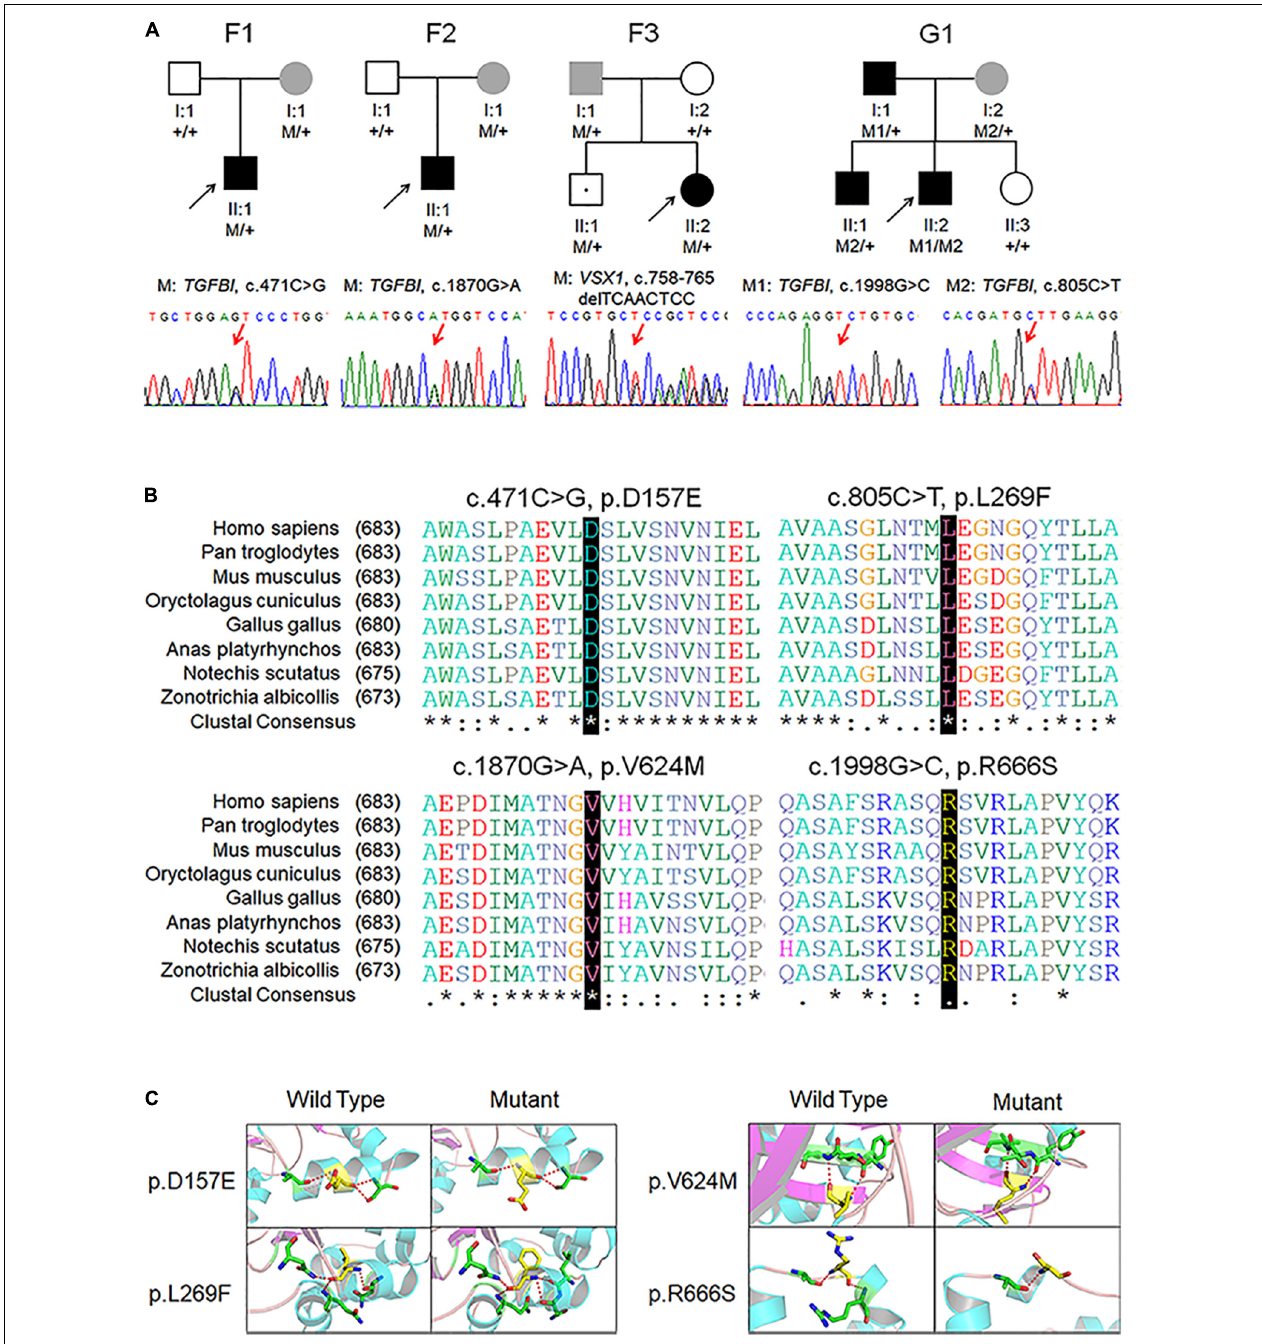
FIGURE 1 | Pedigree, genotype, and clinical data of four probands with keratoconus. (A) Pedigree charts. Black symbol indicates affected member, white symbol indicates unaffected individual, gray symbol indicates member with subclinical keratoconus, and dotted symbol denotes variant carrier without any clinical feature. M represents a variant, and + indicates normal allele. The sequence chromatogram with red arrow represents mutant type. (B) Conservation analysis revealed evolutionary conservation of the variants. (C) Predicted three-dimensional structure of